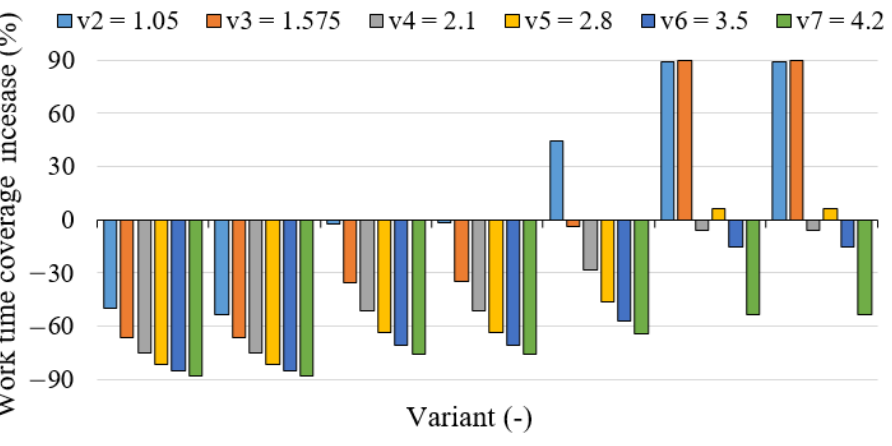
Figure 14. Change in work time coverage in relation to the experiment variant and the simulated wheelchairs’ velocities.